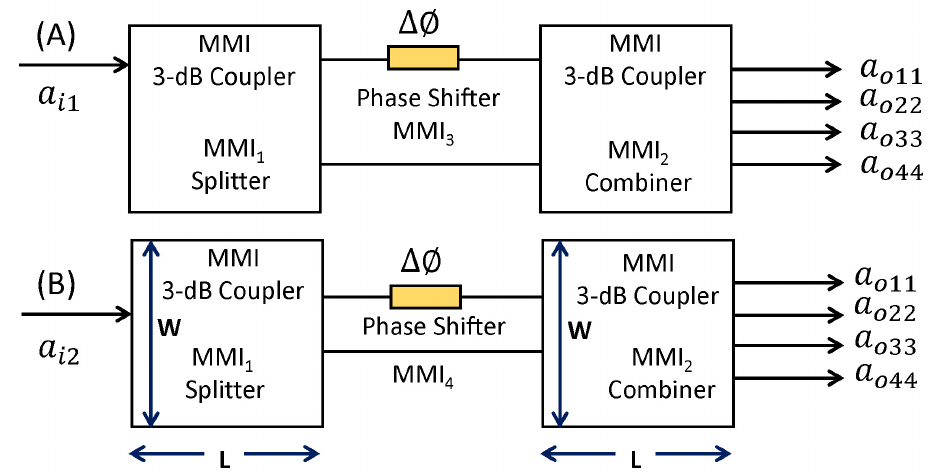
Figure 2. The schematics showing the principle of operation of optical switches. It shows the top view of the MMI 1 / MMI 2 , and phase shifters MMI 3 / MMI 4 , and corresponding waveguide width, length, and positions of access waveguides. The device parameters were calculated using MATLAB Mode Solver [18] as well as FDTD simulation [19]. The device acts as two independent optical switches depending on whether the input is fed through a i 1 ( A ) or a i 2 ( B ).